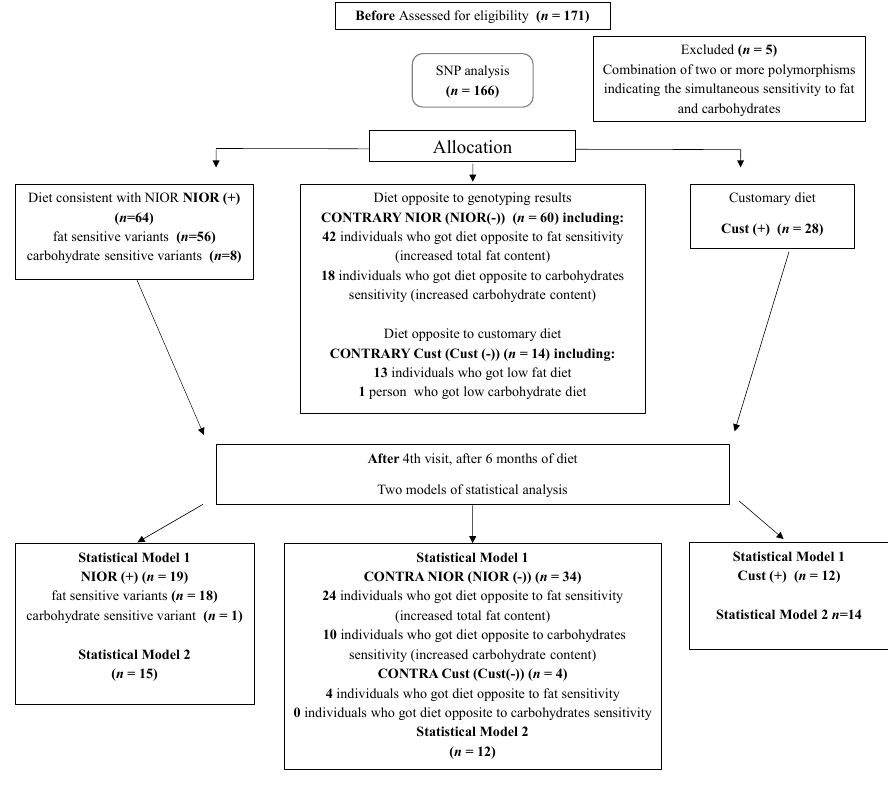
Figure 2. Flowchart for the selection of individuals from the nutrient-induced insulin output ratio (NIOR) cohort. Participants entering subsequent phases of the study as well as dropouts out are indicated in the total. NIOR (+) represents individuals consuming a diet consistent with the results of genotyping; Cust (+), individuals consuming a diet comprising the typical dietary recommendations for non-alcoholic fatty liver disease (NAFLD); NIOR ( − ) and Cust ( − ), individuals consuming a diet contrary to the genotyping results.